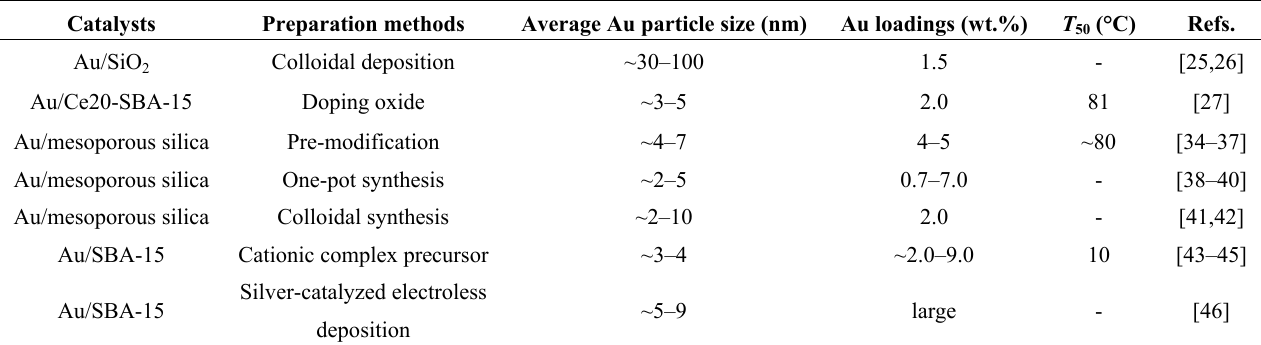
Table 1. Main data of research papers on CO oxidation over Au/mesoporous silica reported in this